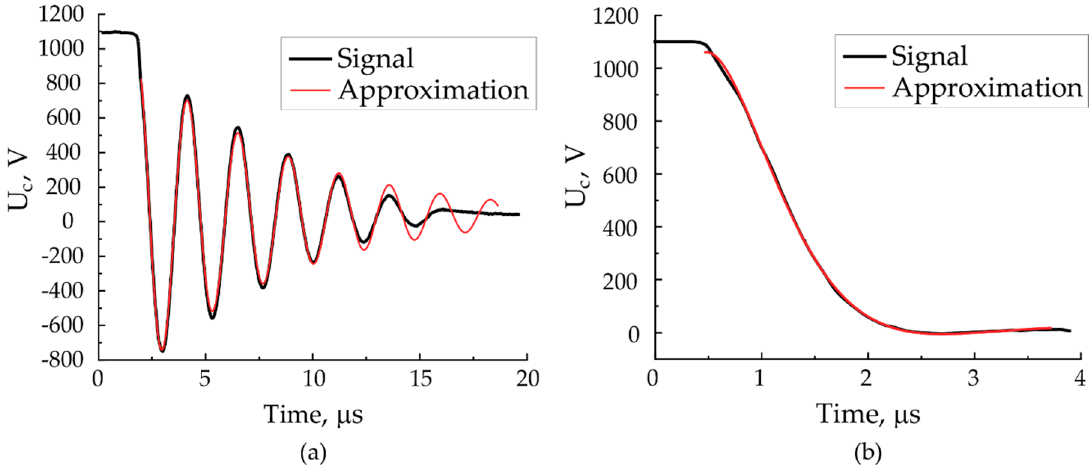
Figure 2. Waveforms of the voltage pulse ( a ) without and ( b ) with a ballast resistor in the electrical circuit for the symmetrical position of electrodes.